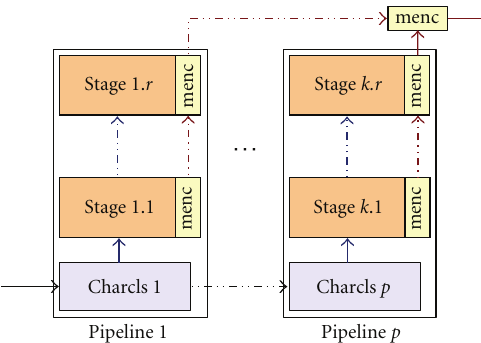
Figure 8: Structure of a 2D staged pipeline with total p pipelines and r stages per pipeline.